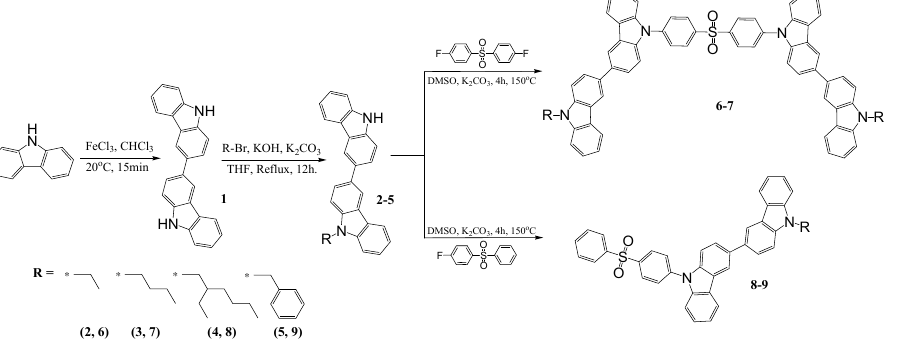
Figure 1. Synthetic pathway of materials DB13 ( 7 ), DB24 ( 8 ), DB34 ( 9 ), and DB43 ( 6 ).